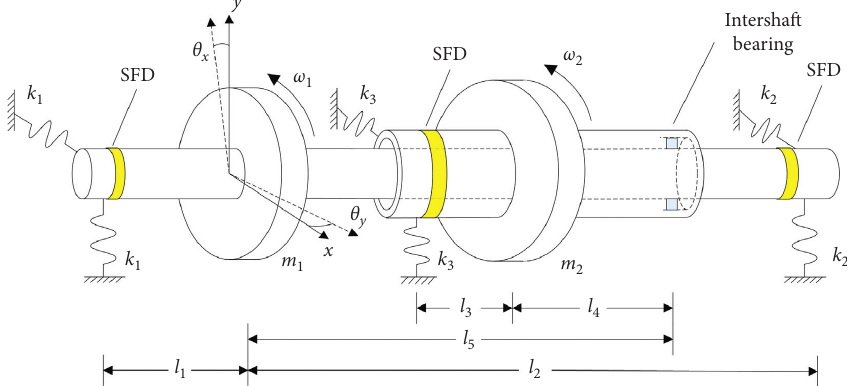
Figure 1: Schematic diagram of the dual-rotor system with intershaft